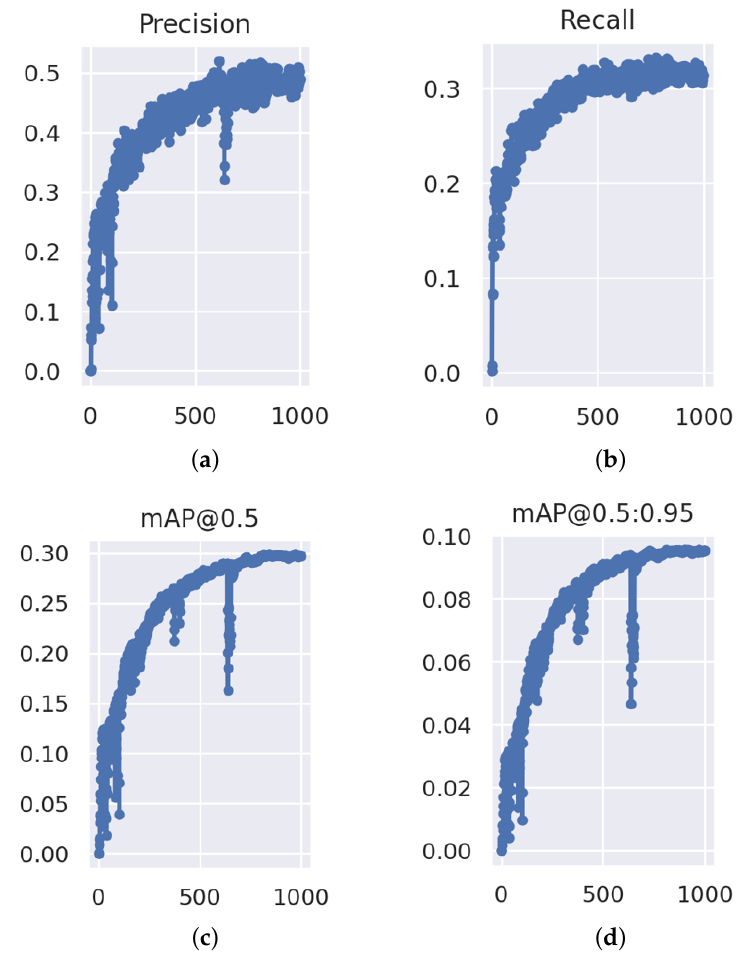
Figure 7. Training curve of TOD-YOLOv7 model. ( a ) is the curve of precision. ( b ) is the curve of recall. ( c ) is the curve of AP@50. ( d ) is the curve of